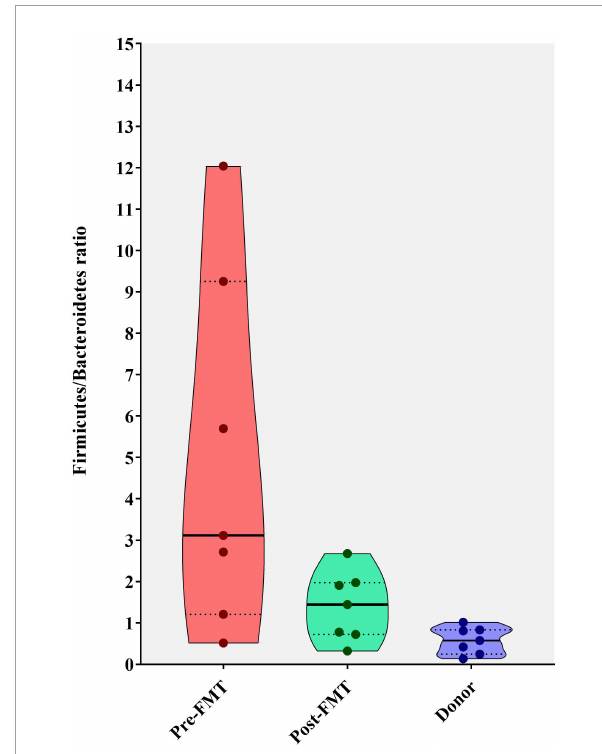
FIGURE5 Violin plots showing the Firmicutes to Bacteroidetes (F/B) ratio in fecal samples of healthy donors, and patients before (pre-FMT) and after (post-FMT) fecal microbiota transplantation (FMT). This ratio was significantly ( P = 0.001) decreased following the FMT (post-FMT) compared with pre-FMT using Mann–Whitney